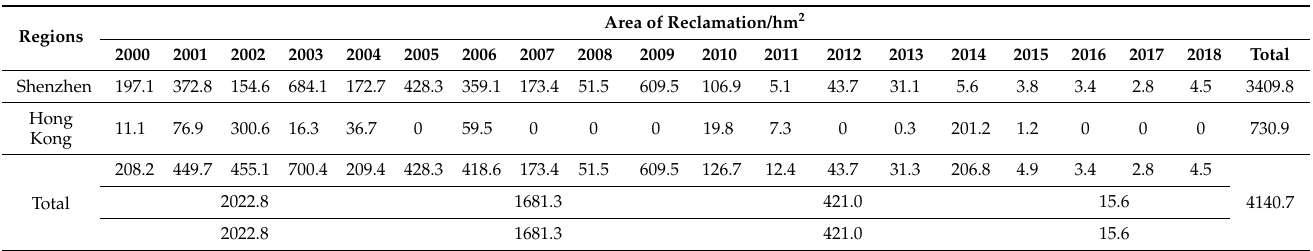
Figure 7. Accumulated areas of the coastal reclamation in Shenzhen and Hong Kong within different five-year intervals. Table 2. Statistics for coastal reclamation areas in Shenzhen and Hong